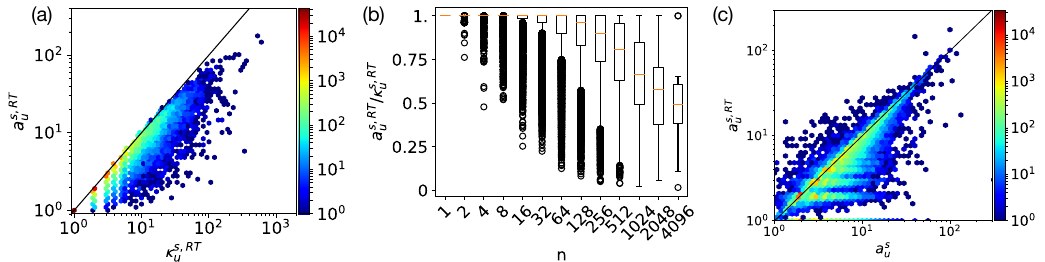
Figure 5. ( a ): Semantic attentional degree as a function of the hashtag set size. ( b ): Ratio between semantic attentional degree and number of hashtags a s u / κ s u (y-axis) as a function of activity as the total n number of tweets and retweets (x-axis). ( c ) Correlation between semantic attentional degrees a s u computed by considering retweeted hashtags, and a s , all u computed by considering any tweeted or retweeted hashtag of a user u . This correlation appears with a Pearson coefficient R = 0.889 ( p -value < 0.05). All heat-map colors code absolute